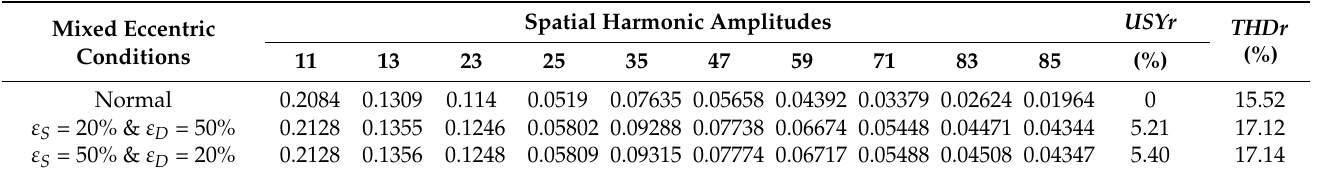
Table 3. The spatial harmonic amplitudes, USYr and THDr with different mixed eccentricities. Mixed